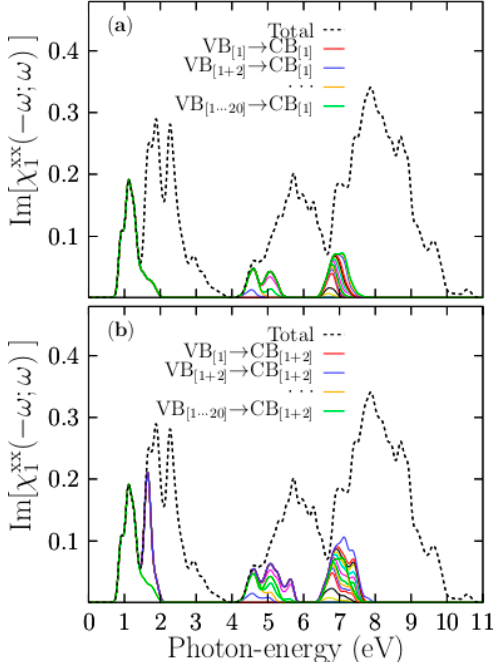
Figure 12. Breakdown of the part of the K 7 Cl 8 :Cu into di ff erent band contributions. The upper panel ( a ) shows the part, taking into account all valence bands with a single bottom conduction band. The lower panel ( b ) shows the part, taking into account all valence bands with the two bottom-most conduction bands. The suspension points, yellow solid line, stand for terms not listed, but which follow the sequence. The black dotted line represents the total χ xx ( − ω ; ω ) part, considering all valence and conduction bands